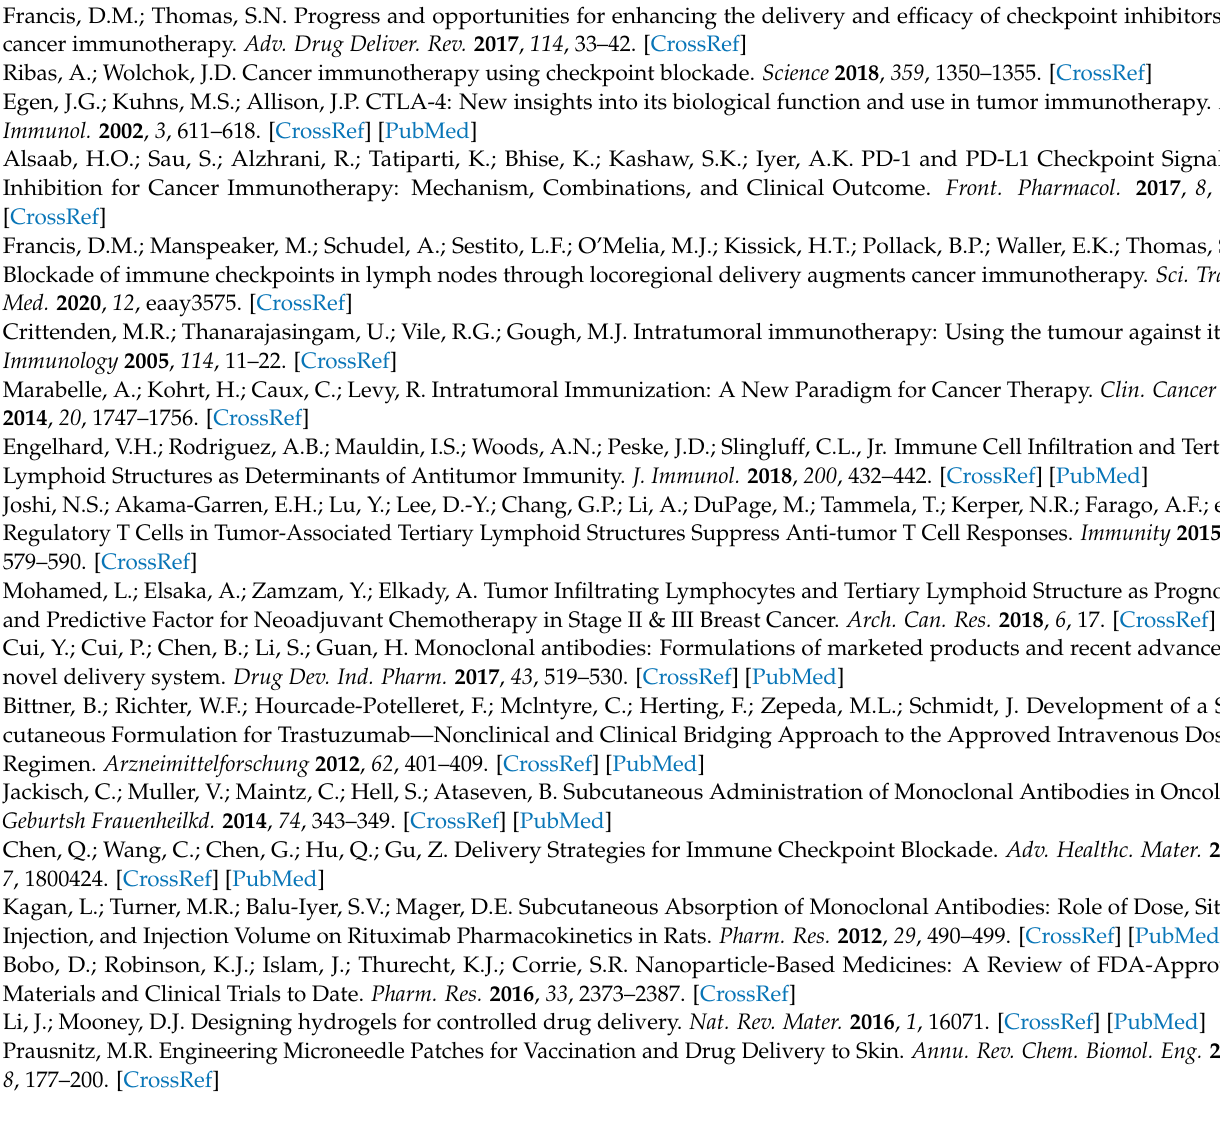
and F127-pSH in D 2 O, Figure S4: Temperature- and concentration-dependent sol-gel transition of F127 and F127-BPEI, Figure S5: Quantification of weight density of polymer thiol groups in F127, Table S1: Sol-gel and gel-sol transition temperature of F127 and